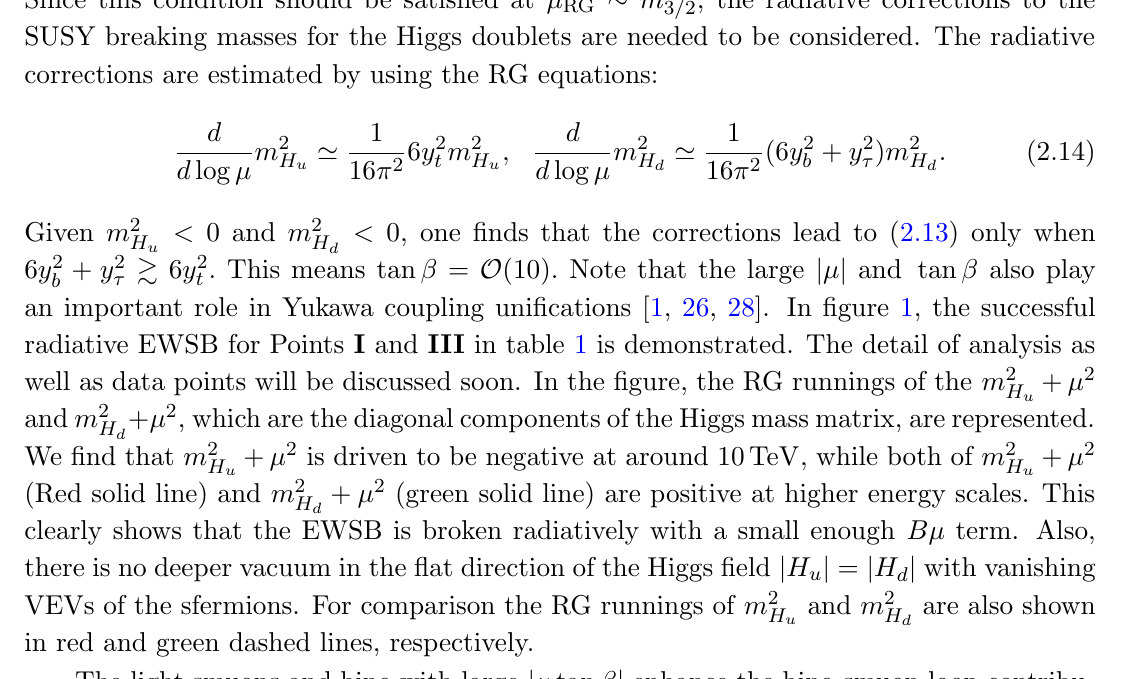
Figure 1 . The radiative EWSB of Point I [left panel] and Point III [right panel]. The red and green solid (dashed) lines represent by varying the renormalization scale. The sign of the y -axis is the sign of the